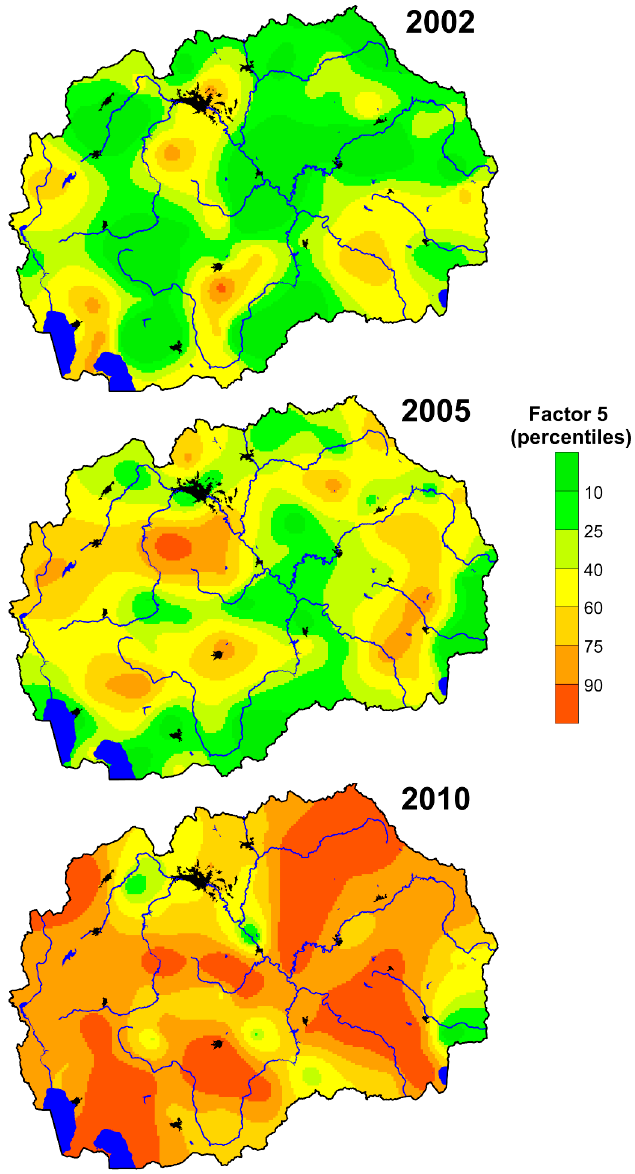
Figure 10. Spatial distribution of F5 factor scores (Br-I)—normal values.